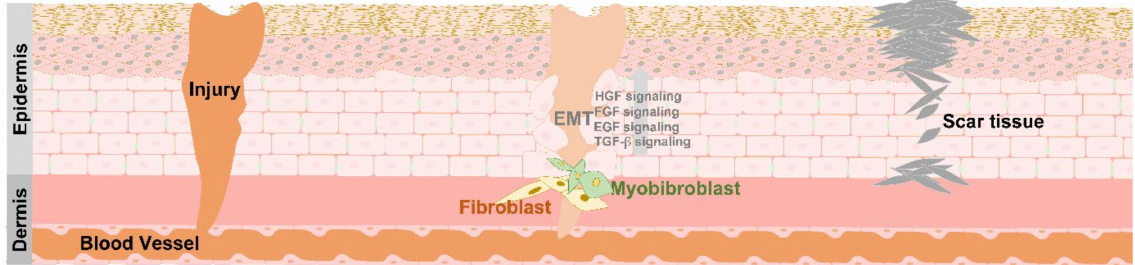
Figure 3. Wound healing progression. The diagram shows wound healing progression. Different signal transmissions interact with neighboring cells through EMT when the tissue is damaged to repair the wound. The related signaling, such as FGF, EGF, TGF-b, and HGF, can induce cell migration by redefined epithelial, mesenchymal, and secret matrix metalloproteinase to remodel extracellular components. In addition, cells, such as Keratinocyte and fibroblast, can undergo the EMT and cellular proliferation process to participate in wound healing-related